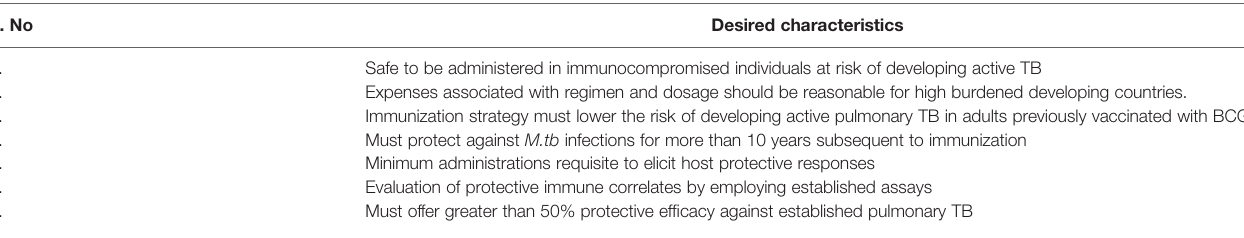
TABLE 1 | Desired characteristics for novel Tuberculosis immunization